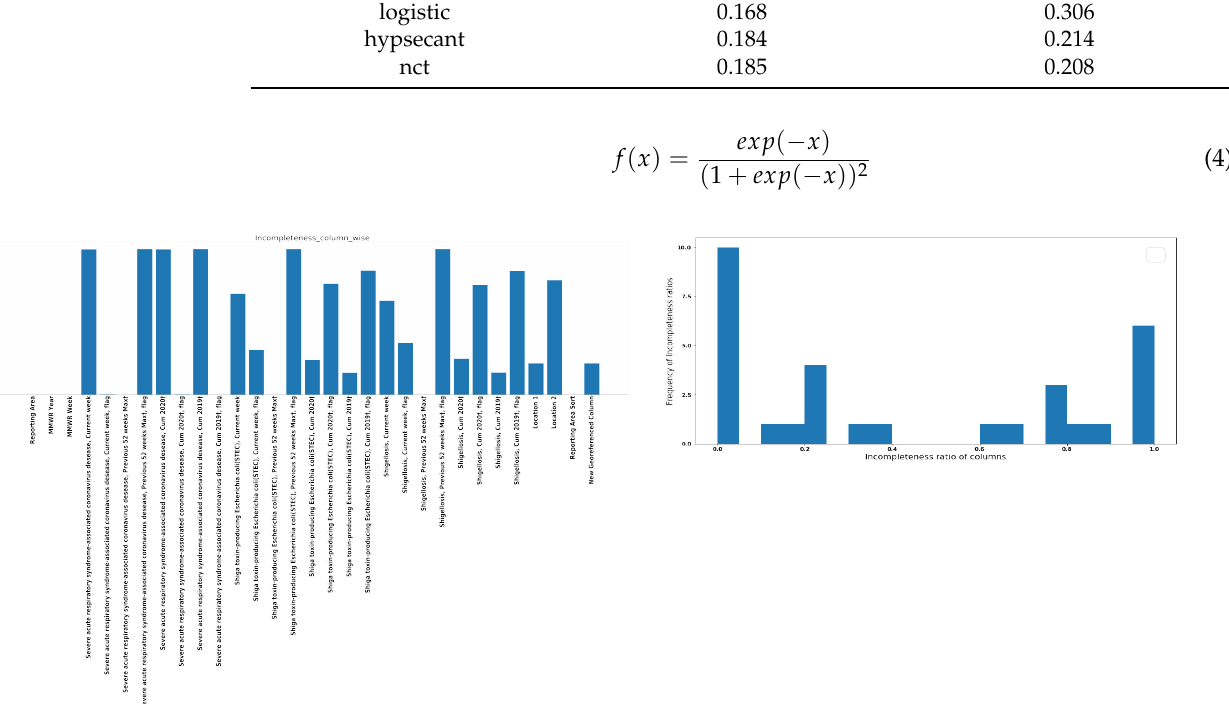
Figure 6. RIS of each column, histogram of the NNDSS